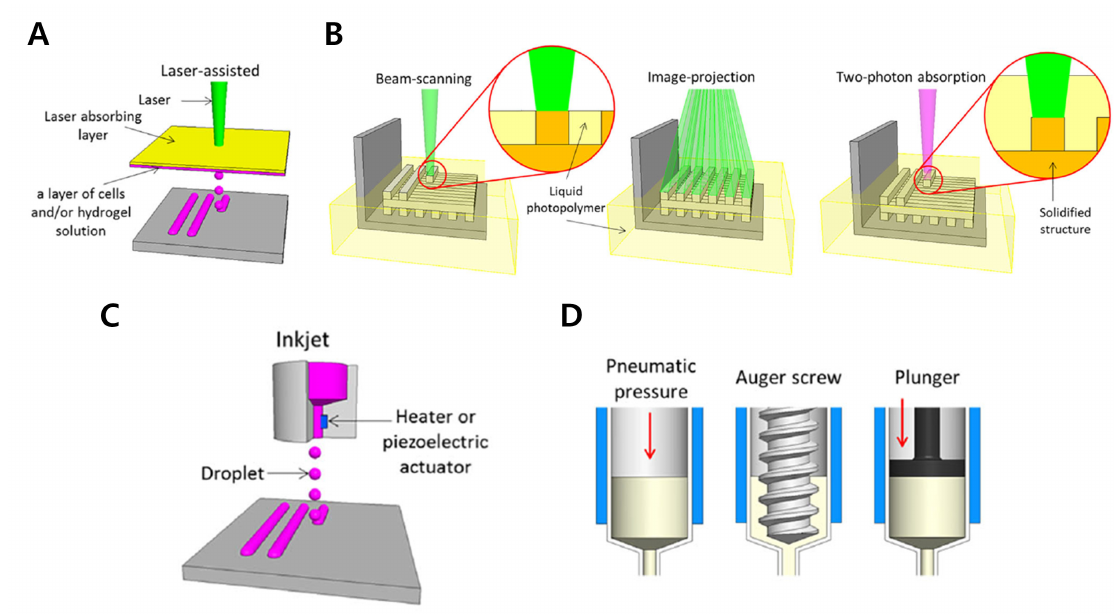
Figure 1. Schematic image of printing methods. ( A ) L IFT -based printing system. ( B ) SLA-based printing system. ( C ) Inkjet-based printing system. ( D ) Extrusion-based printing system (reproduced with permission from ref [20]; copyright 2016 Springer